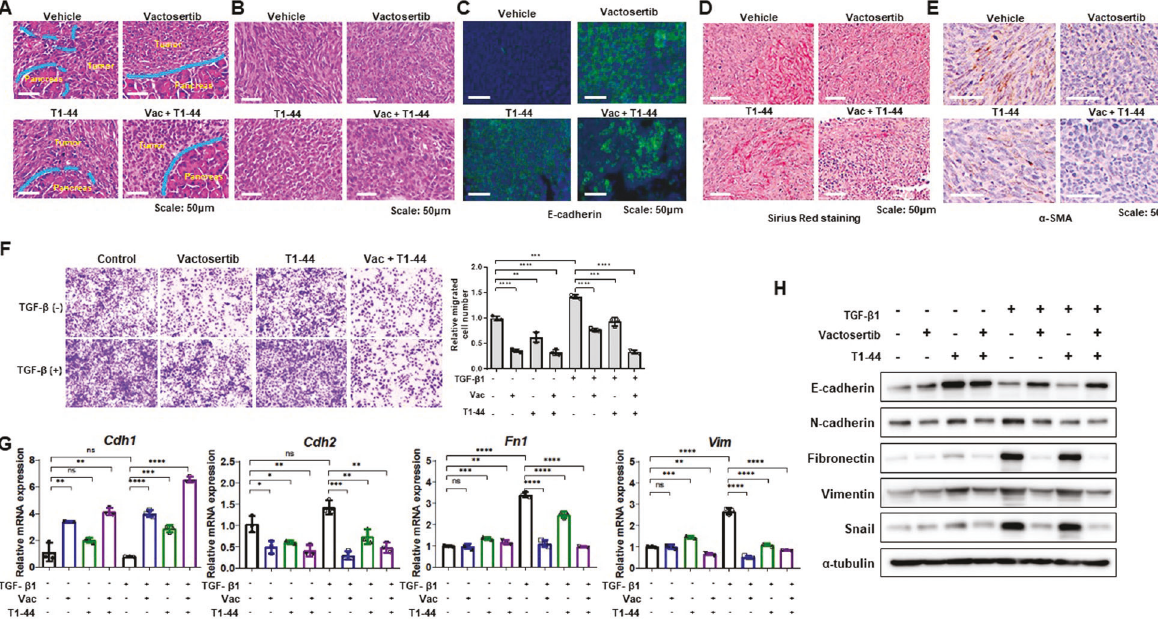
Fig. 3 Inhibition of tumor invasion and fi brotic change of surrounding tissues through regulating EMT-related genes. A Histological analysis of pancreas tumor and normal tissues. Border lines between tumor and normal tissue were drawn by blue lines. Broken part of lines represents invading structure of tumor. B H&E images showing cell morphologies of each group. Spindle type (vehicle) and round type (Vactosertib, T1-44, and Vac + T1-44). C Immuno fl uorescence staining results of E-cadherin in tumor tissues. D Sirius Red staining indicating collagen deposition (strong red color) in tumor surrounding tissues. E α -SMA immunohistochemistry-stained tumor tissues (brown). F Panc02 cell migration assay using trans-well system. TGF- β 1 (5 ng/ml), Vactosertib (Vac) (500 ng/ml), and T1-44 (5 μ g/ml) were primarily treated for 48 h. G mRNA levels of EMT markers using quantitative PCR data. H Protein levels of EMT markers using western